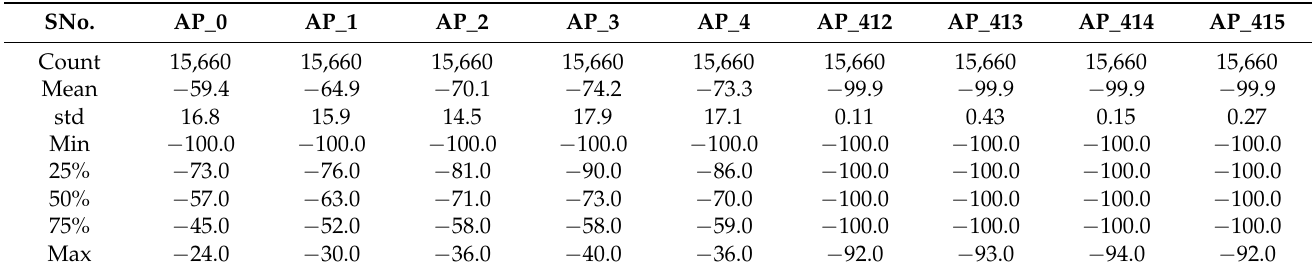
Table 2. The distribution and descriptive measures of the Offline RSS measures.